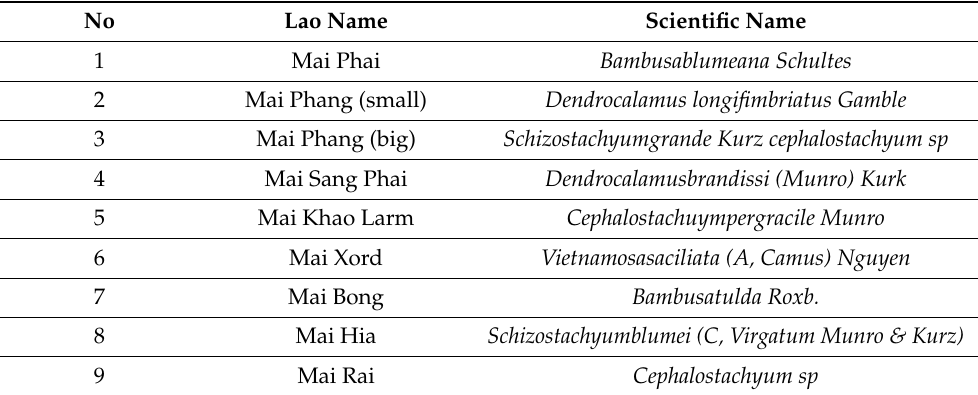
Table 2. List of Bamboo species in Sangthong district, Lao